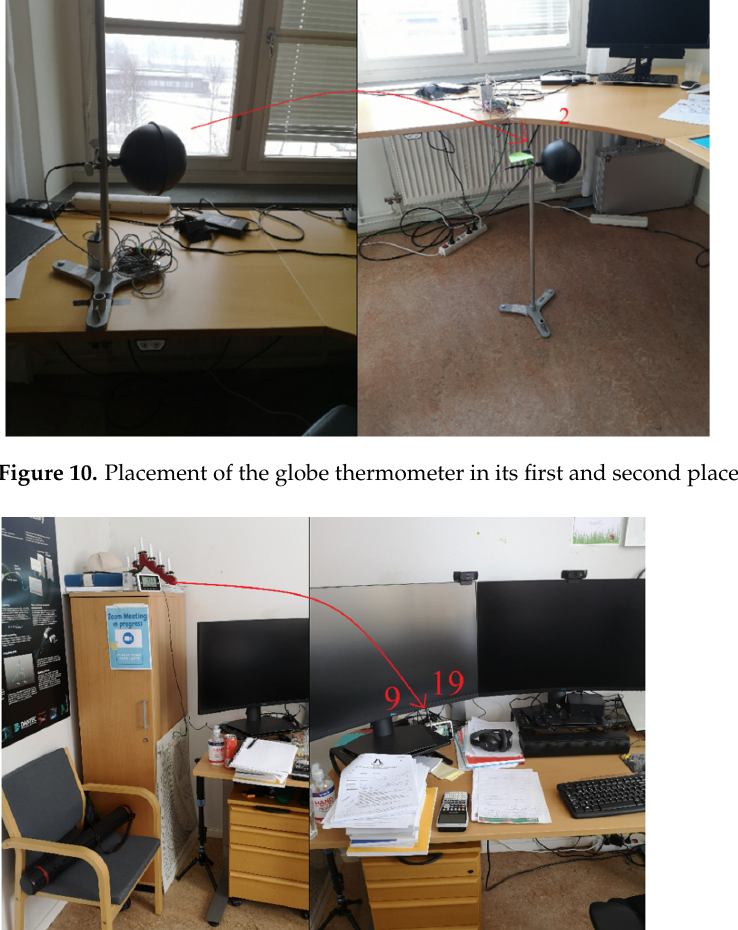
Figure 12. Placement of logger 14 (at the supply inlet) in Room C. 2.6. Outdoor Measurements The loggers 15 and 16 were placed outdoors. The logger 15 was placed on a windowsill facing northwest on the 3rd floor, that is, the floor below the rooms where the measurements were performed. The logger was shaded all day except in the evenings. In addition, the logger 16 was placed on the back of a sign that was located north of the building (see Figure 13). The logger’s location was exposed to sunlight for approximately four hours in the morning and two hours in the afternoon. At the University of Gävle, there was a measuring station where values for air temperature and relative humidity outside were collected.